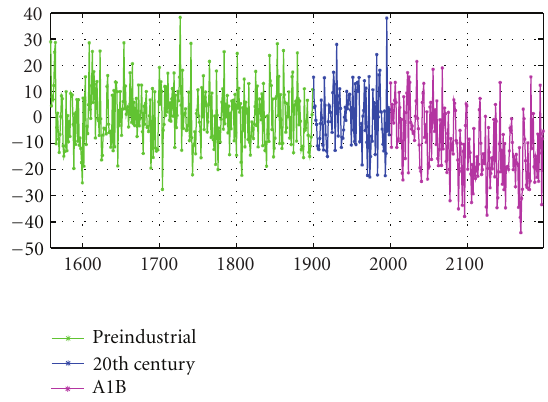
Figure 7: Time evolution of the rainfall EOF1 for the preindustrial run (green), the 20th century run (blue), and the A1B scenario (magenta). The time series are constructed projecting the precipi- tation anomalies, calculated with respect to the climatology of the 20th century, onto the spatial pattern of